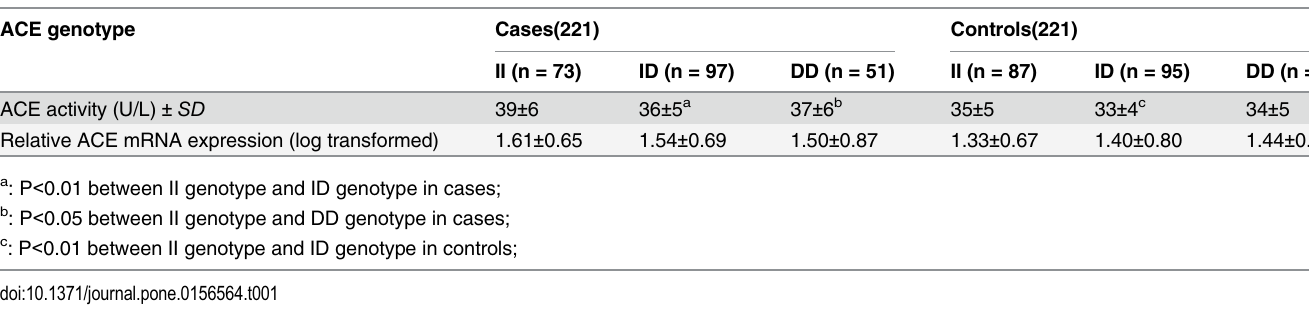
Table 3. Effect of ACE genotype on ACE activity between the cases and